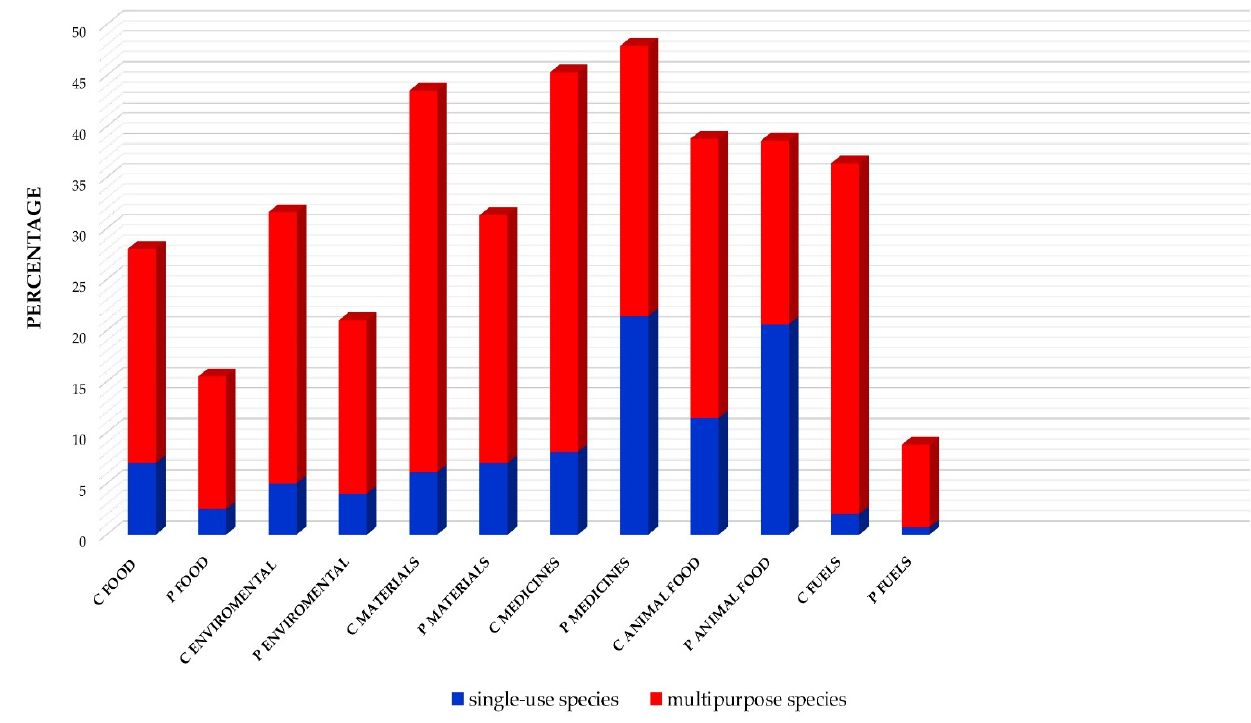
Figure 5. Comparison of percentage values of eight selected categories in Caesalpinioideae (C) and Papilionoideae (P). Categories percent values correspond to Tables 3 and 4, that are based on Supplementary Materials (Figures S2 and S3). The distance coefficients displayed in Papilionoideae assume a minimum value of